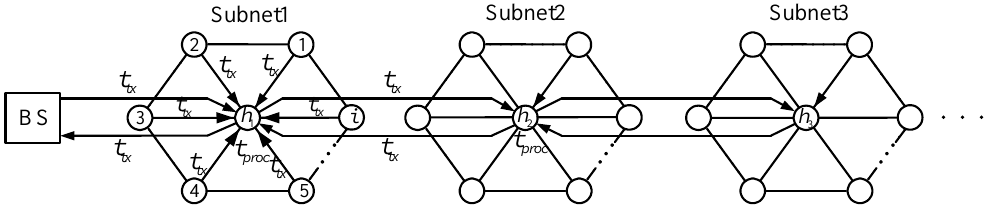
Figure 8. Process of transmission delay without bad